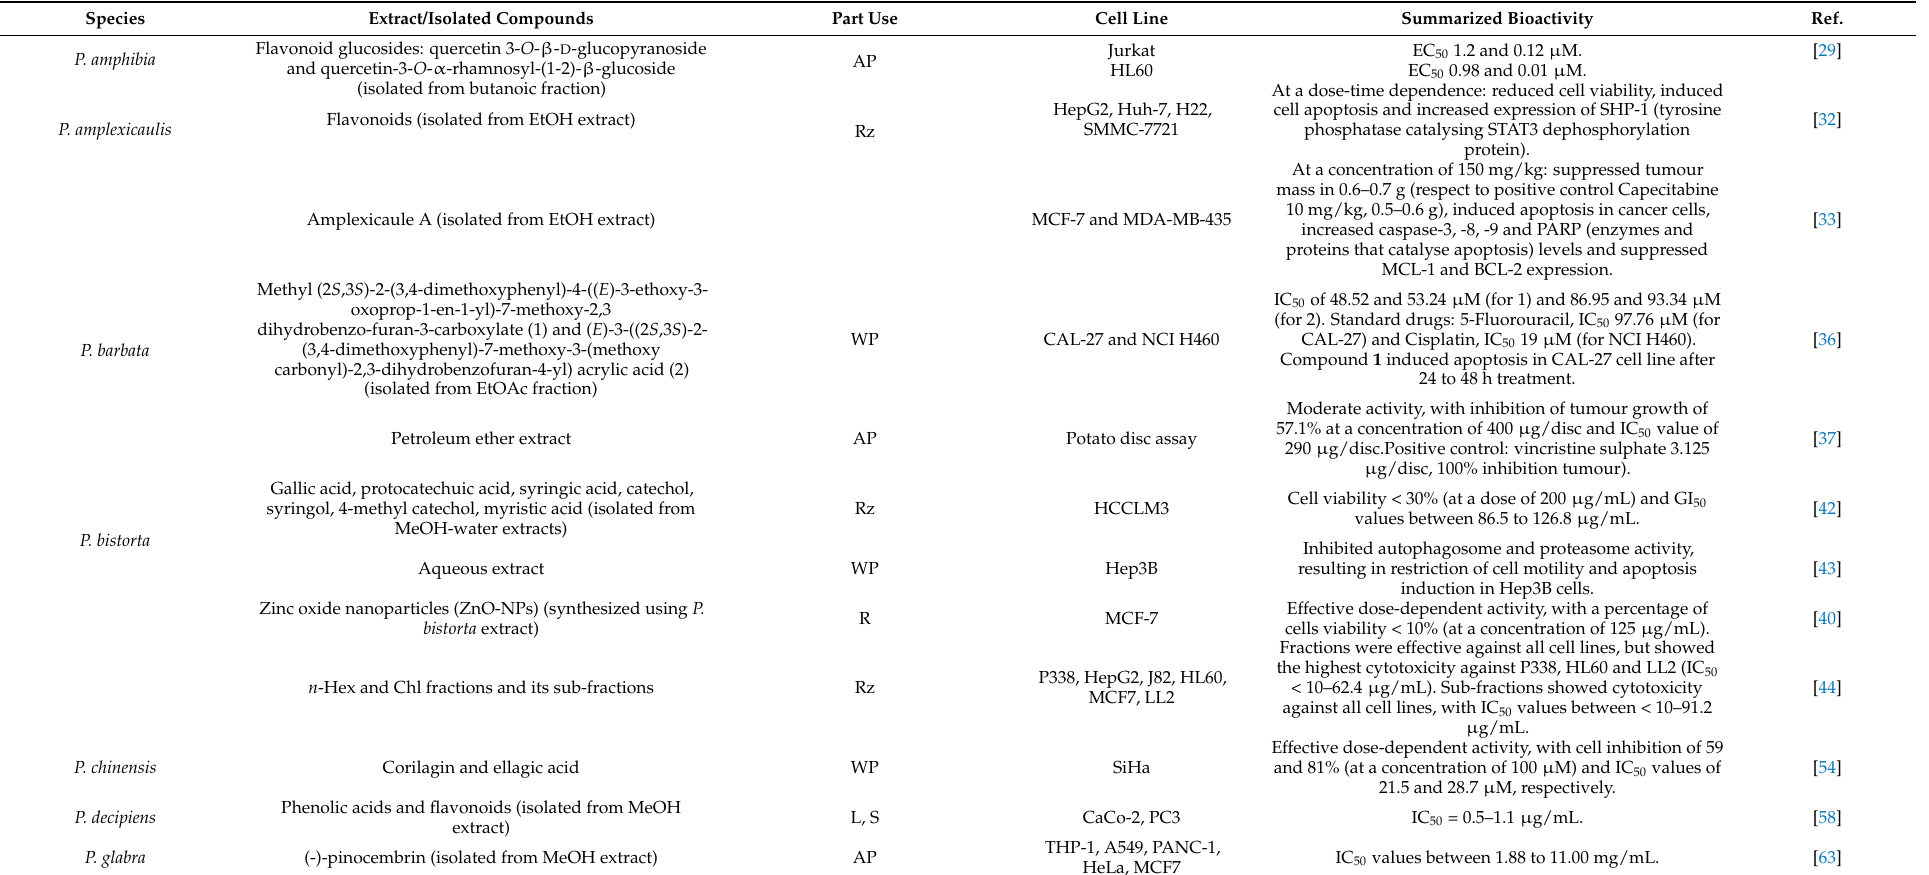
Table 5. Anticancer and antitumoral activities of Persicaria and Polygonum species. Extracts, compounds, part of plant used, cell line and references are shown. Extracts: EtOH (ethanol); MeOH (methanol); Chl (chloroform); Hex (hexane); EtOAc (ethyl acetate); But (butanol). Part used: L (leaves); F (flowers); Fr (fruits); R (roots); Sp (sprouts); S (seeds); St (stems);